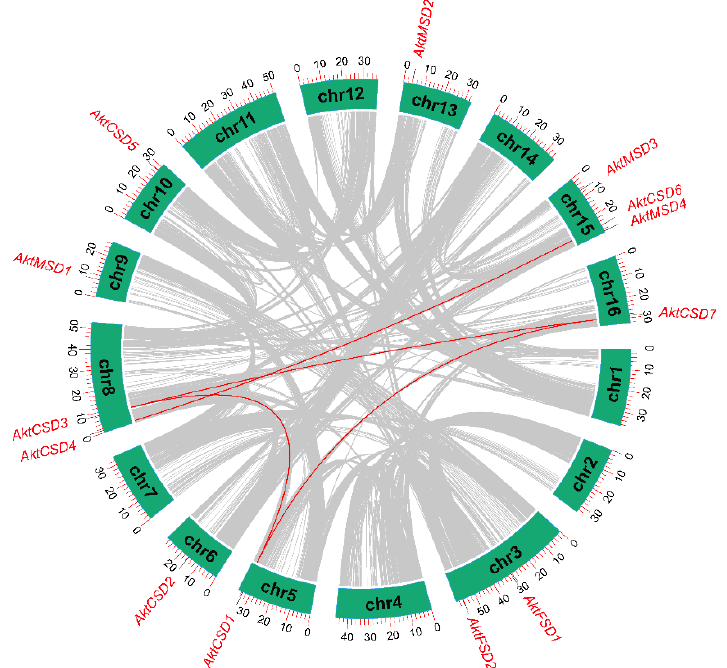
Figure 3. Chromosomal localization and interchromosomal synteny of AktSODs . Red lines in the inner circle represent syntenic gene pairs from WGD/fragment duplications.